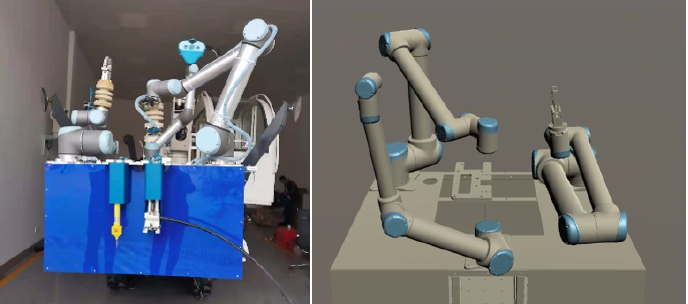
Figure 21. Test platform and simulation verification